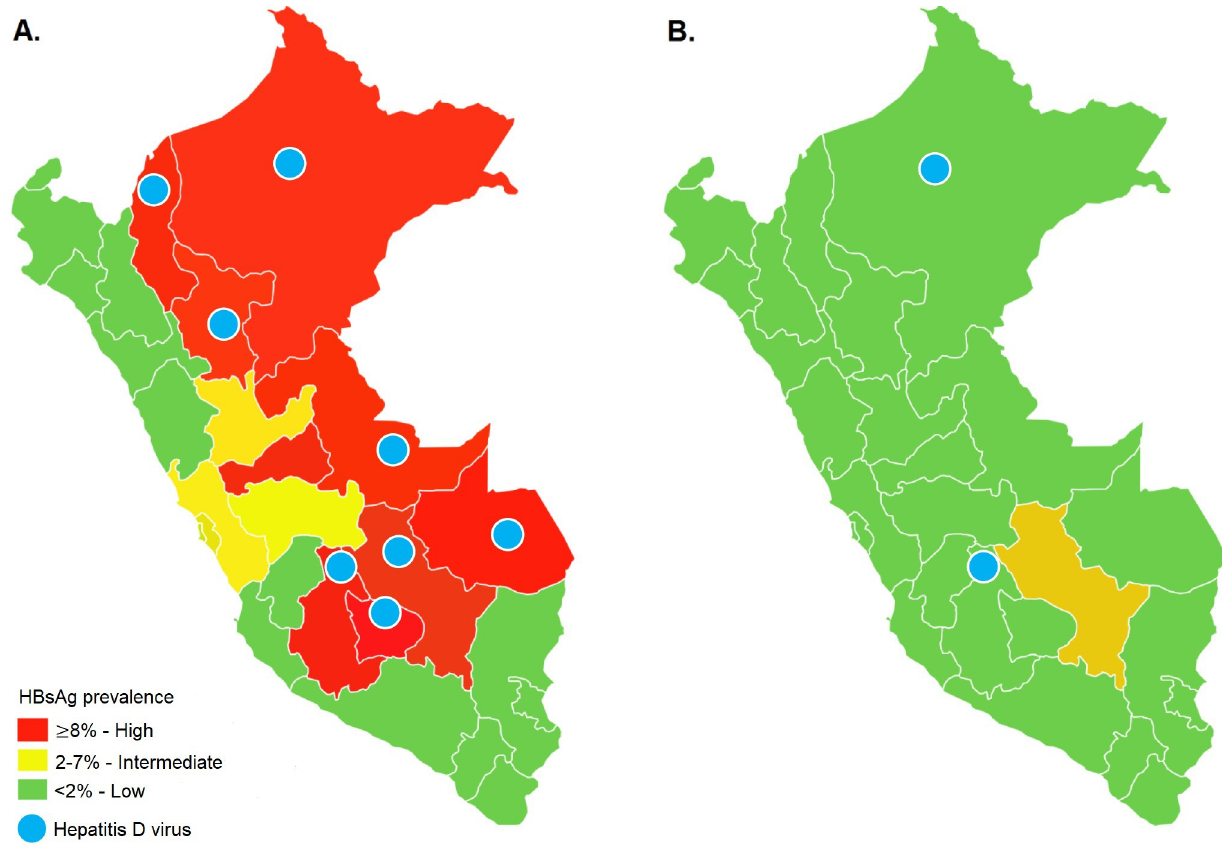
Fig 3. Prevalence of HBsAg and hepatitis Delta before (A) [19] and after the implementation of the hepatitis B vaccination program in Peru (B).